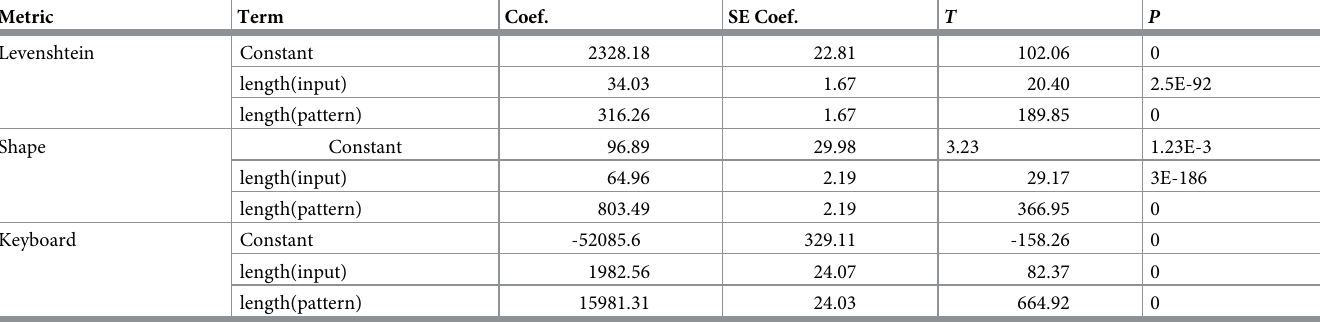
Table 2. Statistical analysis using a regression approach according to the edit distance metric.